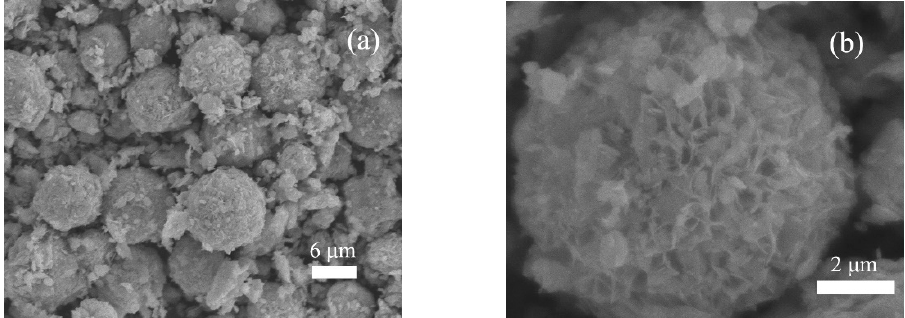
Figure 4. ( a ) Low magnification scanning electron microscope (SEM) image; ( b ) high magnification SEM image of the 1.5L-ZIS sample.